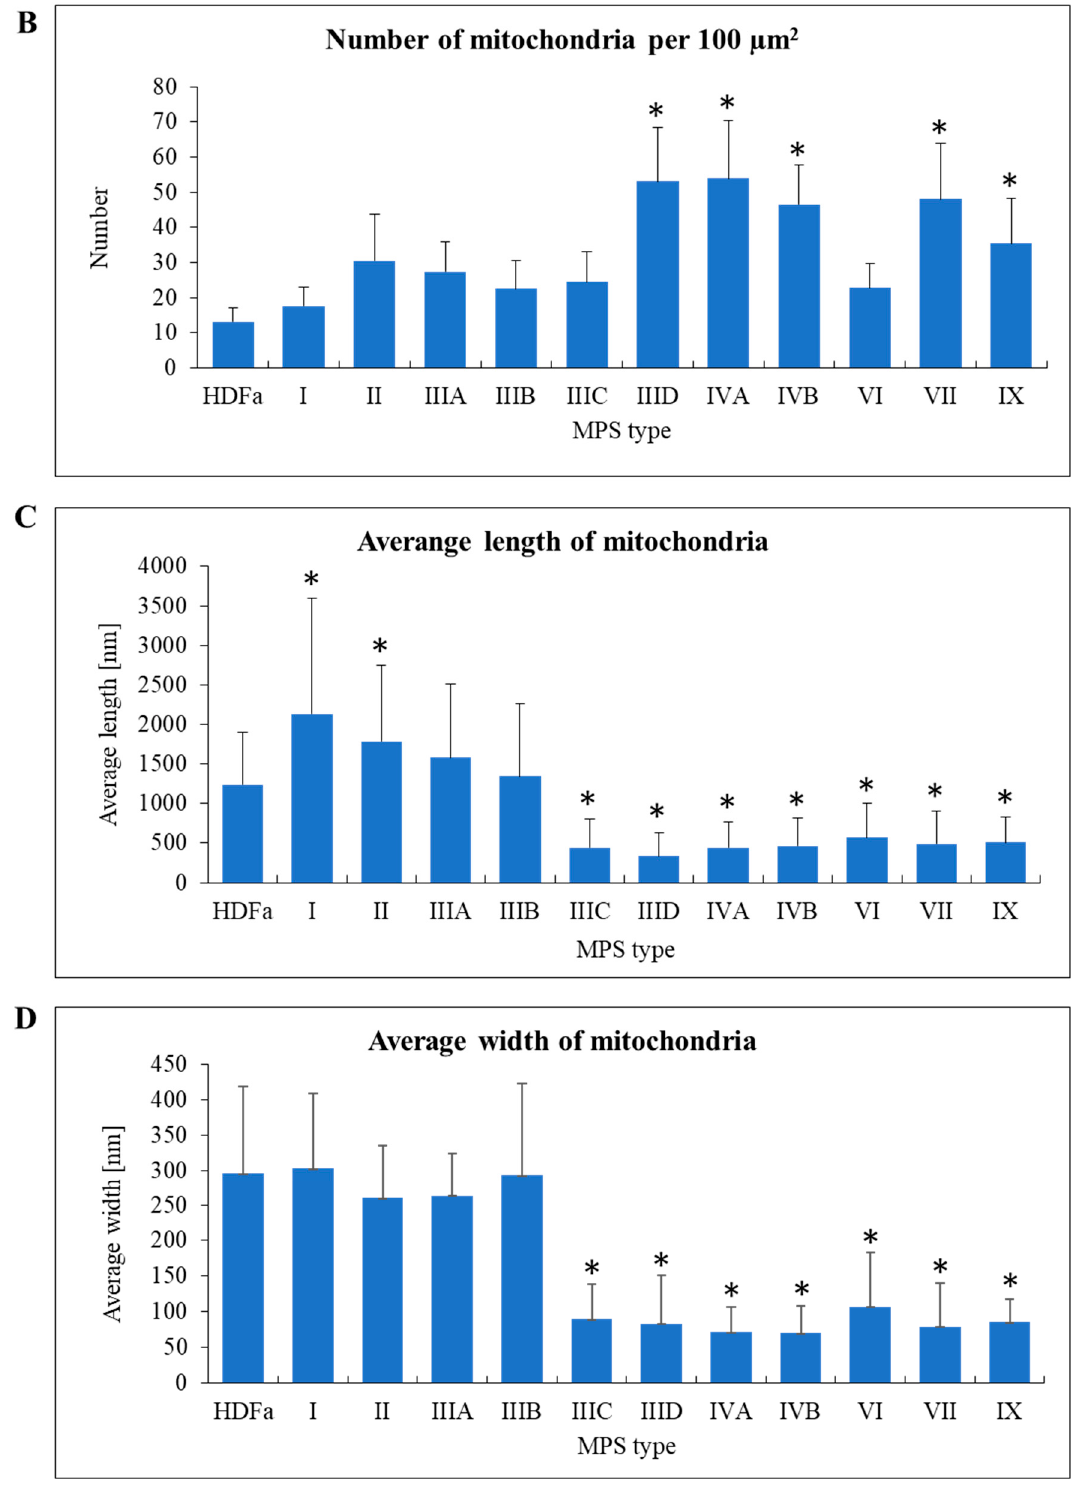
Figure 7. Morphology of mitochondria in MPS fibroblasts in comparison to control cells (HDFa cell line). Representative electron micrographs are presented in ( A ) (size bars represent 500 nm; arrows indicate mitochondria). Quantification of changes in mitochondria is presented in ( B – D ), indicating their number ( B ), length ( C ) and width ( D ). Mean values ± SD are presented, with asterisks representing statistically significant ( p < 0.05) differences relative to the HDFa control.